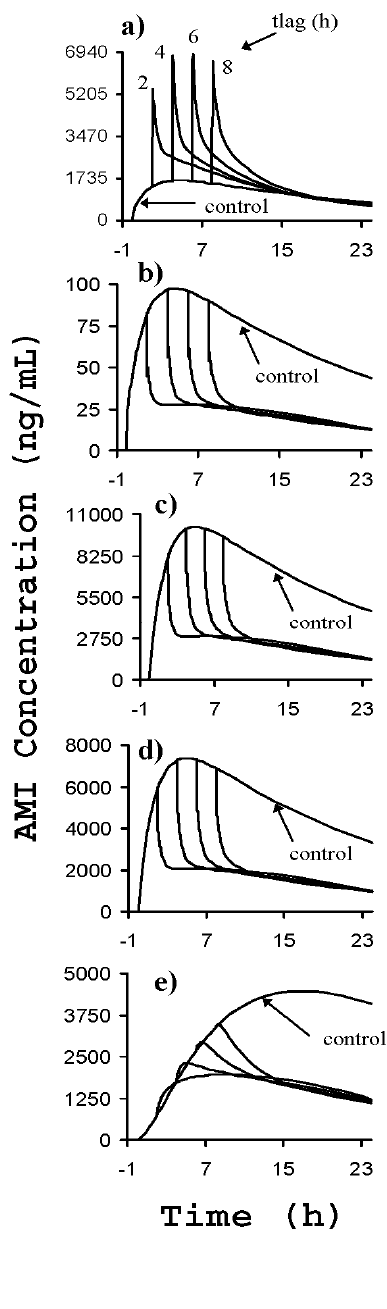
Figure 8. Amitriptyline concentrations versus time for simulated overdose cases (2500 mg) without liposomes and with liposomes at 1.44 g lipid/L for t a) venous whole blood, b) free AMI in venous blood, c) heart, d) brain, and e) muscle. T